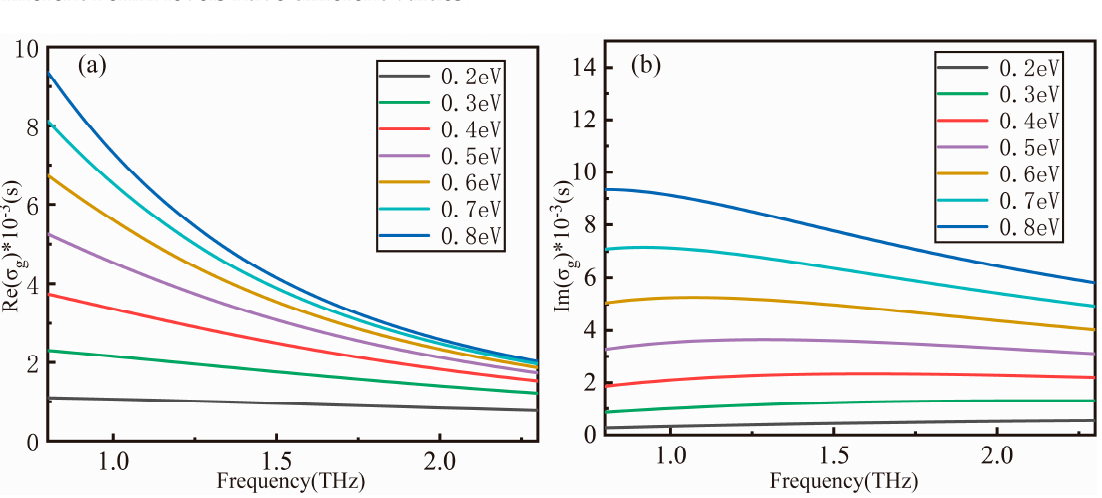
Figure 2. The conductivity of graphene calculated according to the formula is divided into ( a ) real and ( b ) imaginary parts.